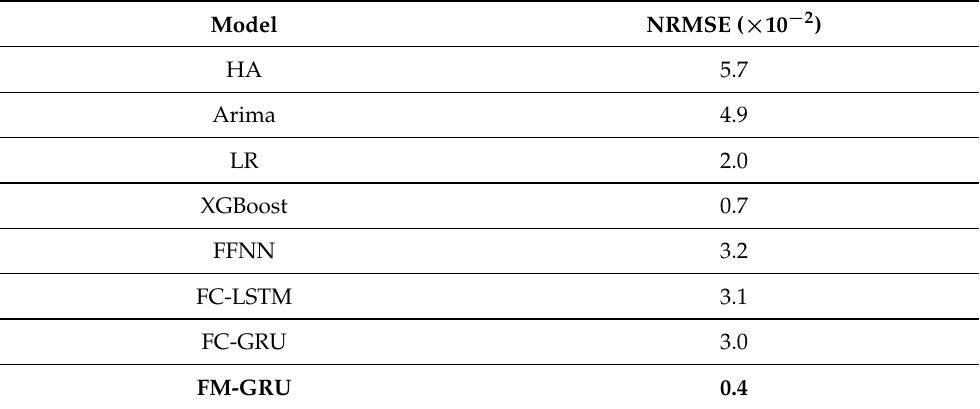
Table 4. Comparison of the performance of different methods in predicting the value of